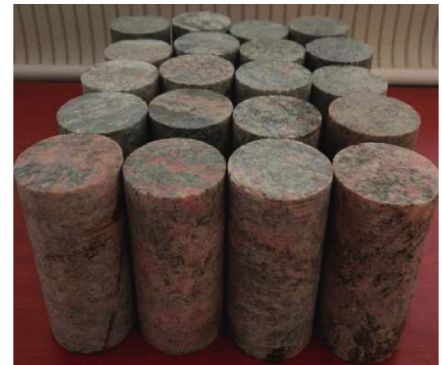
Figure 5: Gneiss